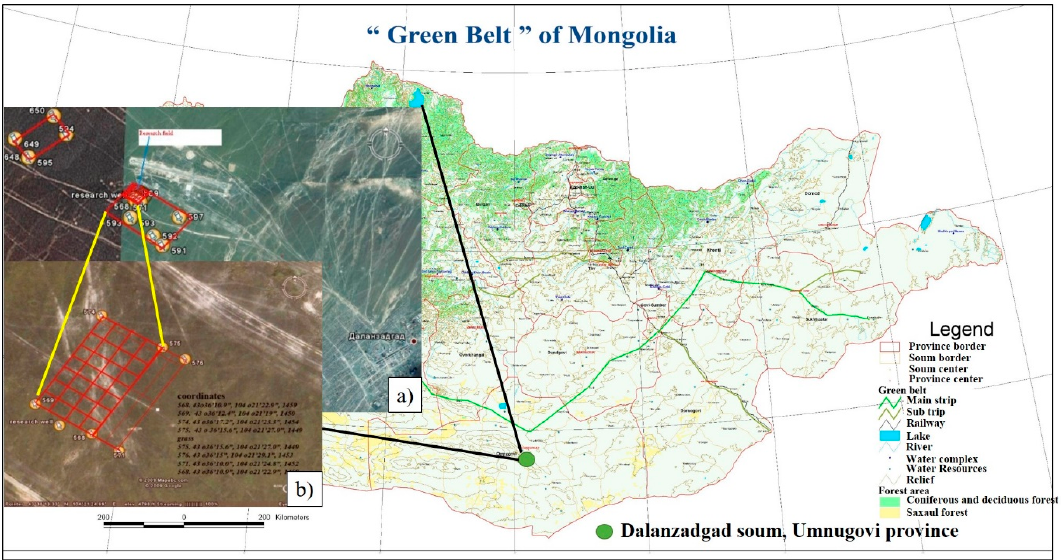
Figure 1. ( a ) Location and ( b ) close-up aerial photo of the experimental site within the Green belt plantation in Dalanzadgad soum, Umnugobi province, Mongolia.